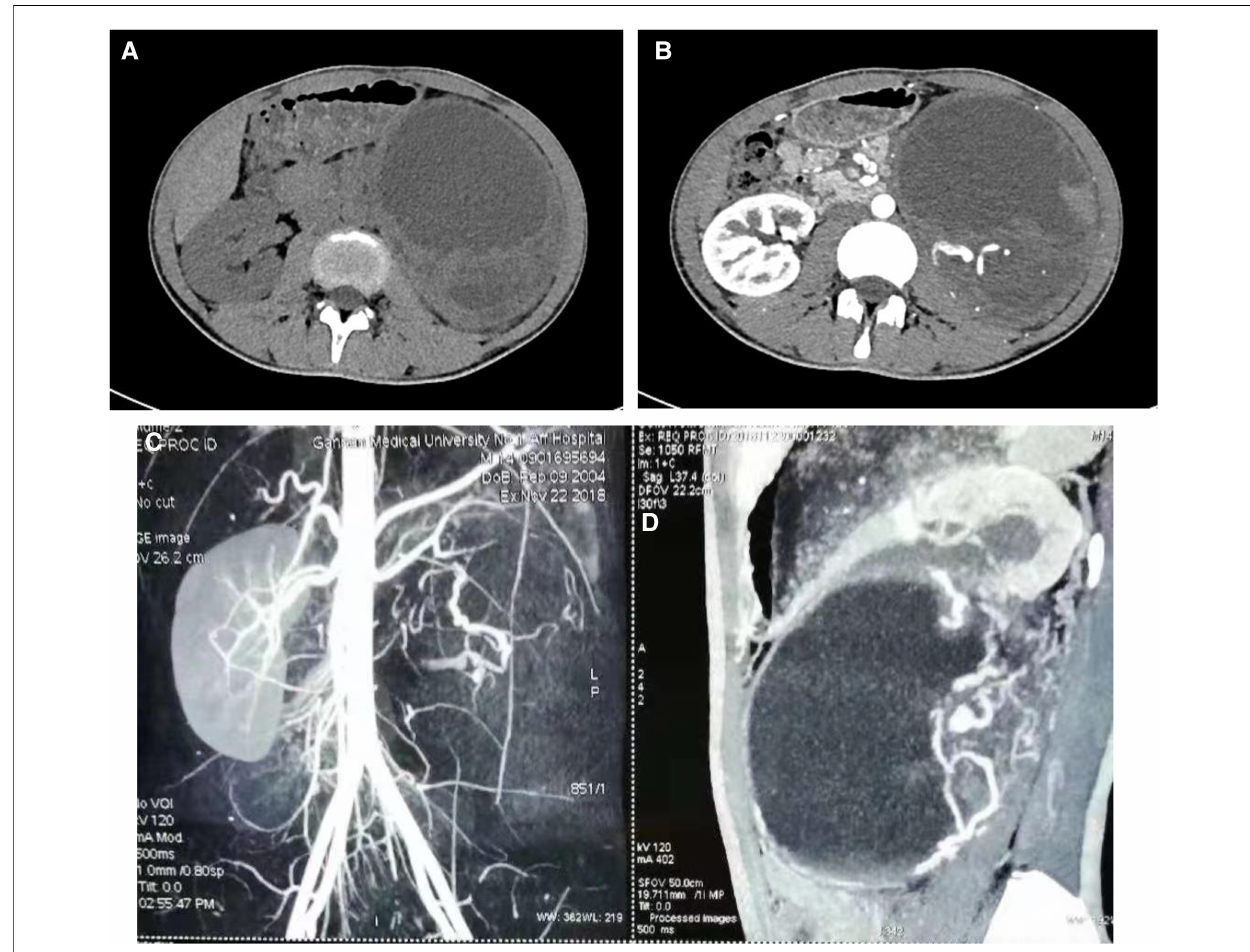
FIGURE 1 Ct scan of the urinary tract. CT scan of the venous phase of the left renal tumor ( A ), enhanced CT scan of the arterial phase of the left renal tumor ( B ), angiography of a tumor in the left kidney ( C ). Sagittal view of the mass ( D